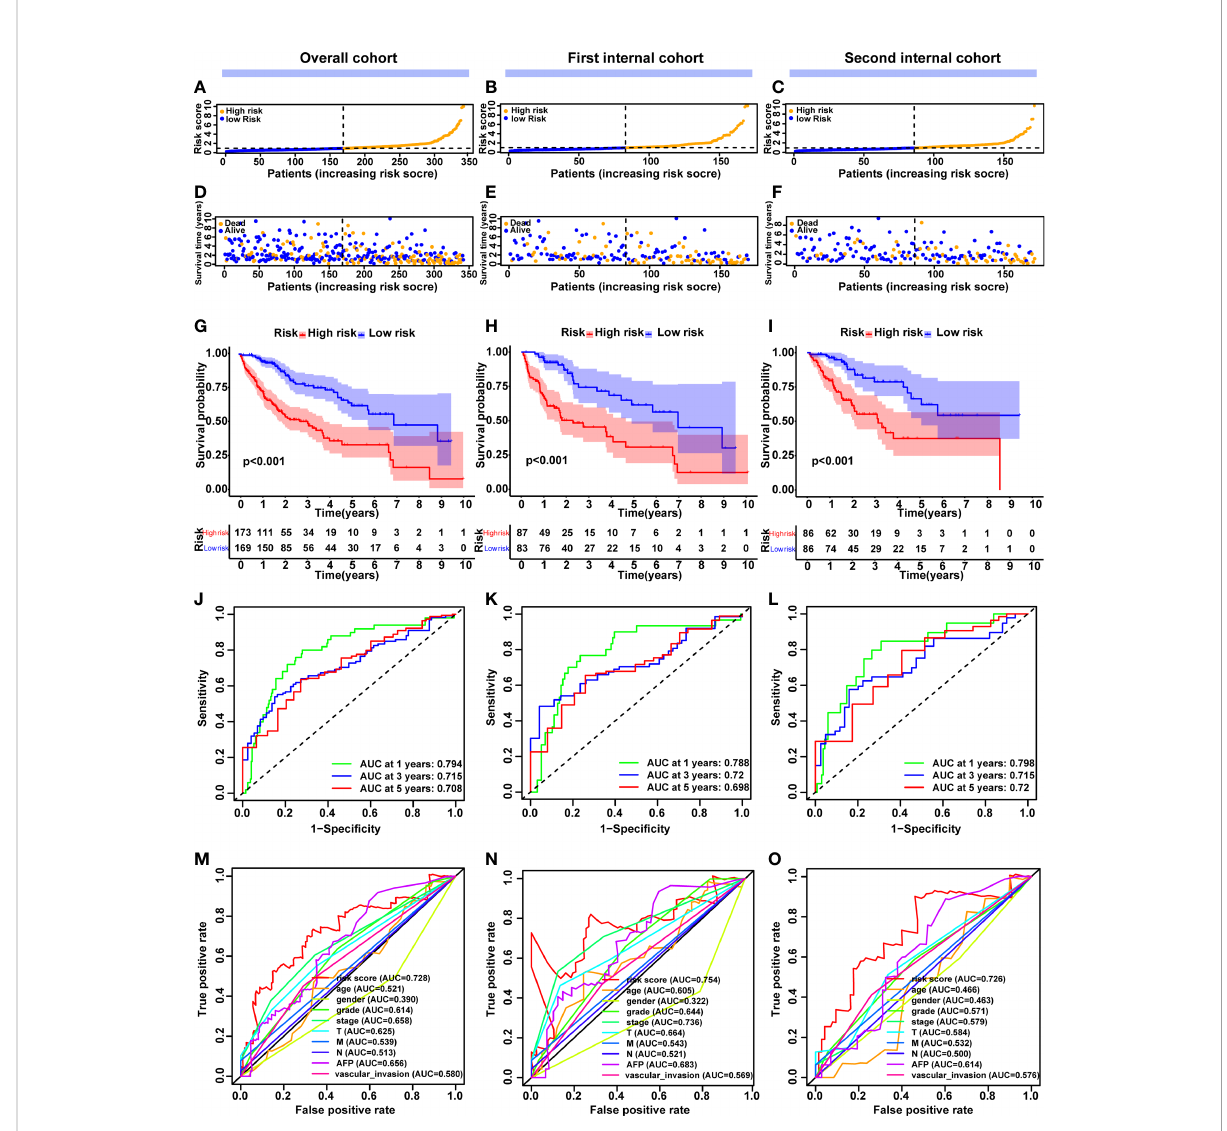
FIGURE 4 Construction and validation of the cuproptosis-related lncRNA signature model in the overall, fi rst internal and second internal cohorts. (A-C) The distribution and median value of the risk scores in the overall, fi rst internal and second internal cohorts. (D-F) The distribution of overall survival status, survival time and risk score in the overall, fi rst internal and second internal cohorts. (G-I) The Kaplan – Meier curves for survival status and survival time in the overall, fi rst internal and second internal cohorts. (J-L) AUC of time-dependent ROC curves demonstrated the ability of the signature of prognostic cuproptosis-related lncRNAs to predict 1-, 2-, and 3-year OS in the overall, fi rst internal and second internal cohorts. (M-O) AUC of ROC curves comparing the prognostic accuracy of the lncRNA signature model and other prognostic parameters in the overall, fi rst internal and second internal cohorts. lncRNAs, long noncoding RNAs; ROC, receiver operating characteristic; AUC, area under the curve; OS, overall